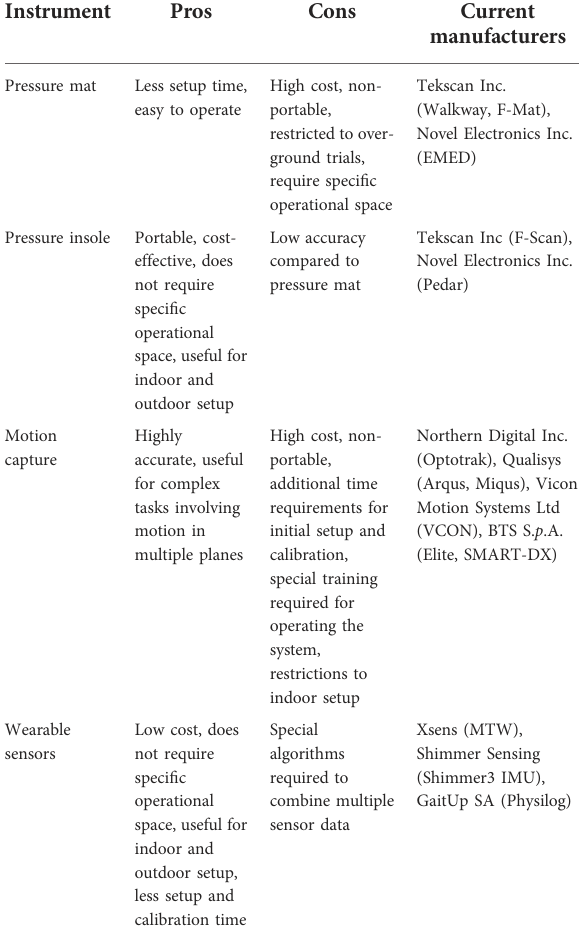
TABLE 5 Pros and cons of different IGA